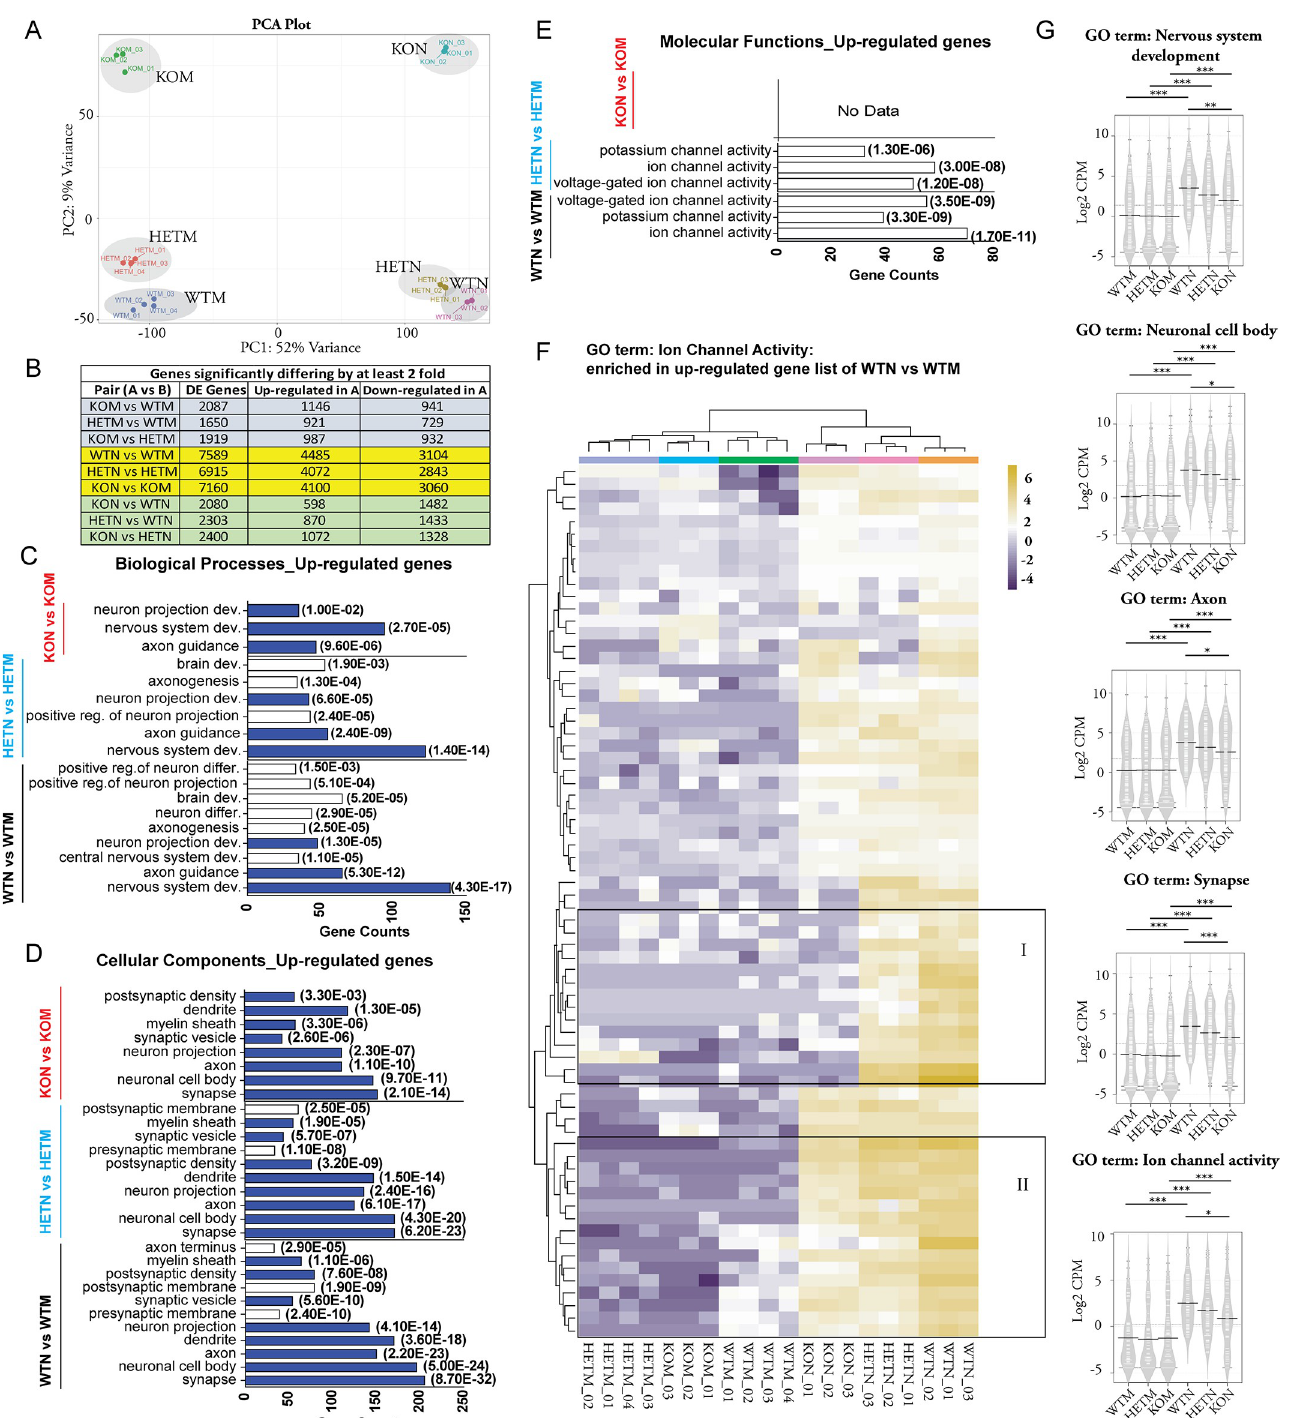
Fig 3. β -actin affects neuron-related transcriptome during direct reprograming in a dosage-dependent manner. (A) Principal component analysis of the transcriptomes of MEFs (WTM, HETM and KOM) and CiNeurons (WTN, HETN and KON). Color spheres represent individual samples. PC1 and PC2 account for 52% and 9% of the total variance, respectively. (B) Summary of the number of genes significantly up-regulated and down-regulated by at least 2 fold in each paired comparison. (C-E) Genes up-regulated in CiNeuron of each β -actin genetic background are subject to GO enrichment analysis respectively. The significantly enriched, neuron-related GO terms (gene counts of the GO term � 30, fold of enrichment � 1.5 and p value of enrichment < 0.01) in Biological Processes (C) , Cellular Components (D) and Molecular Functions (E) are shown. (F) Genes that are associated with ion channel activity and are significantly up-